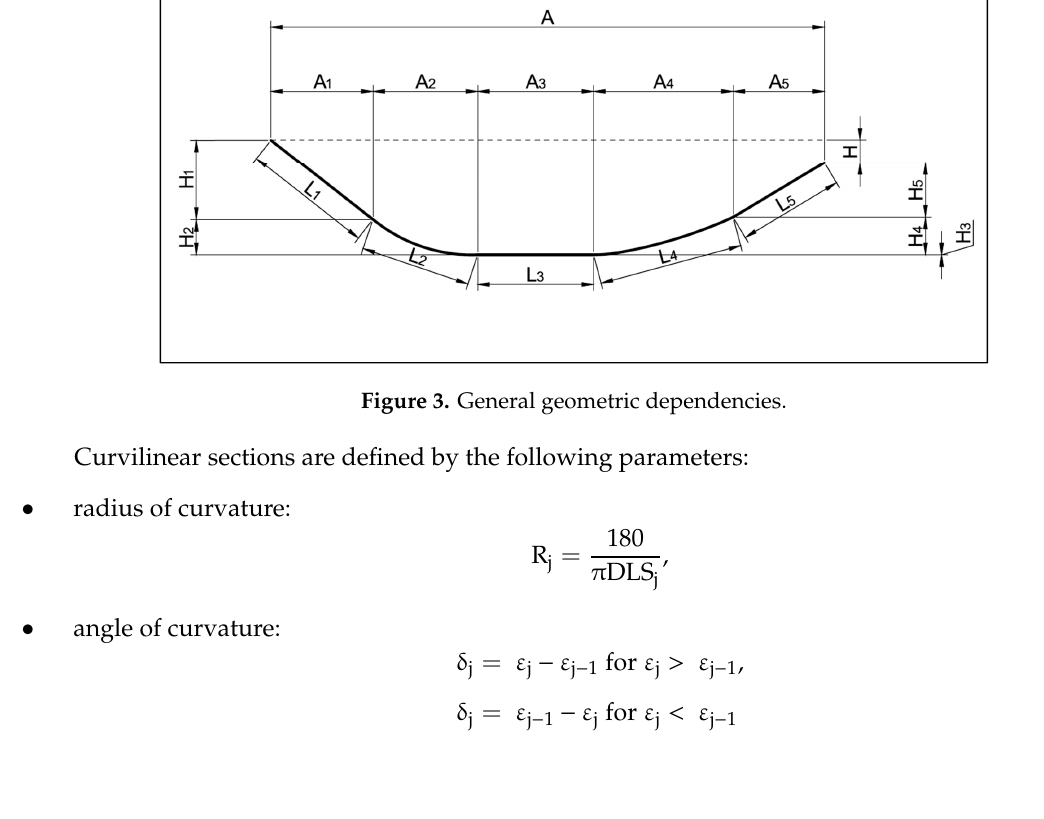
Figure 3. General geometric dependencies.